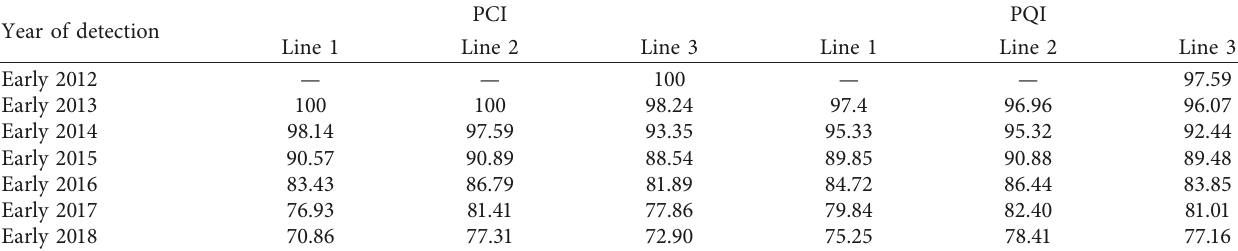
Table 1: PCI and PQI of three typical representative lines of the main highway in Hunan Province.